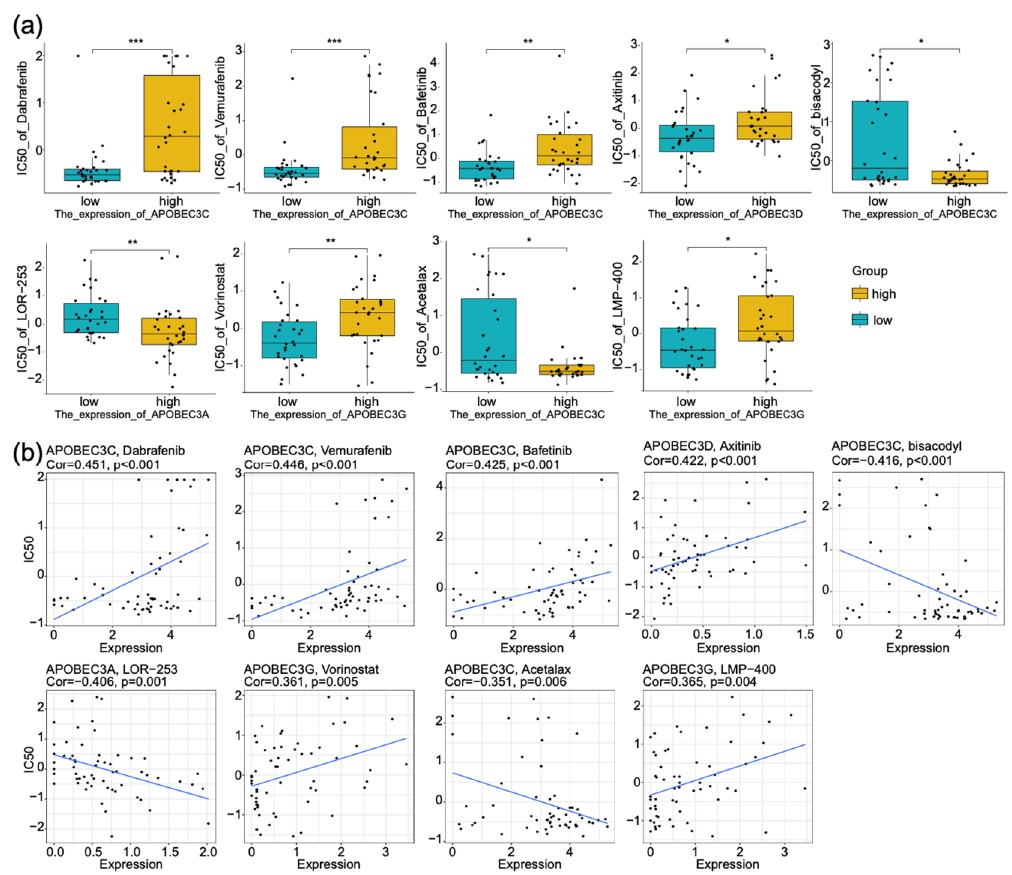
Figure 8. Effect of APOBEC3 family on drug sensitivity of tumor cells based on NCI-60 cell line data. Boxplot ( a ) and scatter plot ( b ) were used to study the relationship between the expression level of APOBEC3 family members and the drug sensitivity of 263 compounds (75 clinically tested and 188 FDA approved drugs) in tumor cells, nine compounds with high correlation were selected to display. p < 0.05, * p < 0.01, ** p < 0.001, *** p < Table 2. Hub gene enrichment analysis by STRING database.